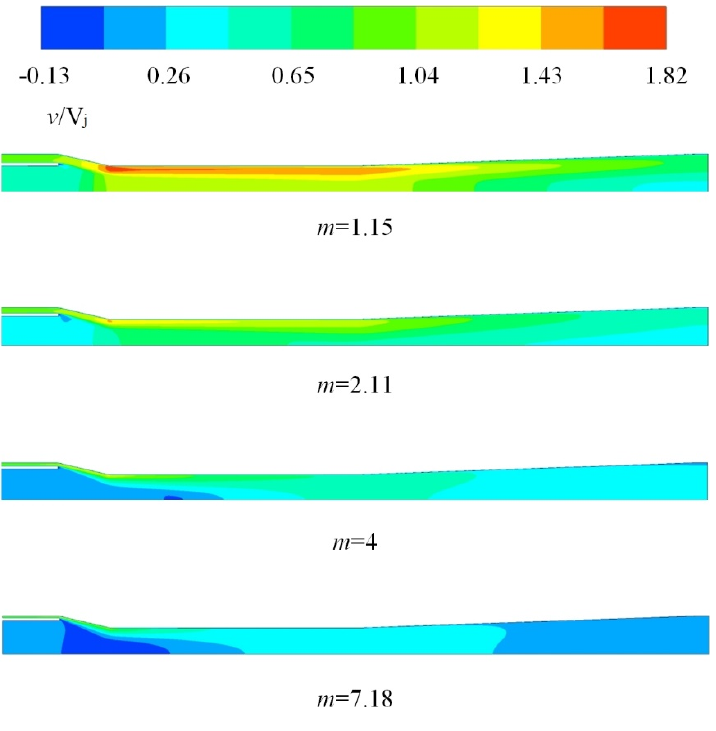
Figure 11. Velocity field of jet pump with different m.